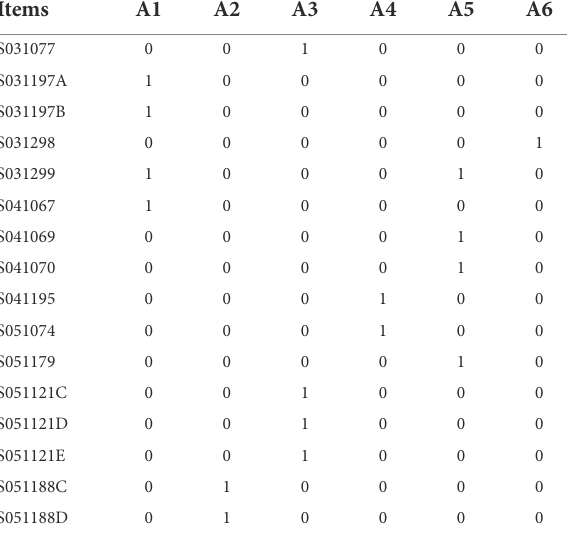
Table 1 Final Q-matrix.